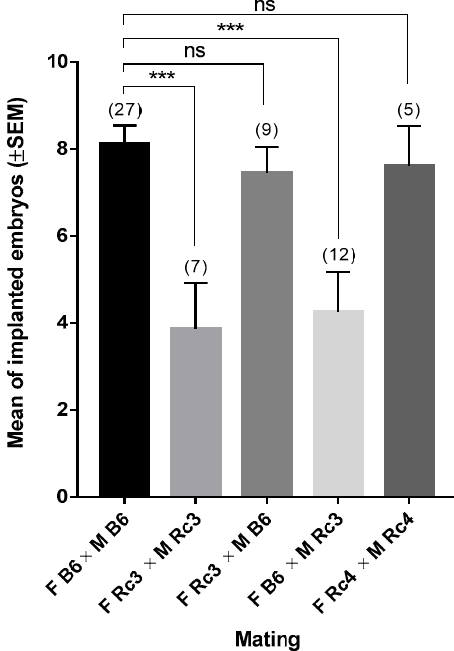
Figure 2. Ultrasonographic examination of the implantation in different crosses using mice from Rc3, Rc4 and B6 strains: Different crosses were performed using males (M) and females (F) from Rc3, Rc4 and B6 strains. The results are presented as the mean (±SEM) of implanted embryos. ( ): number of gestations. ns: non significant. * **: p < 0.001.